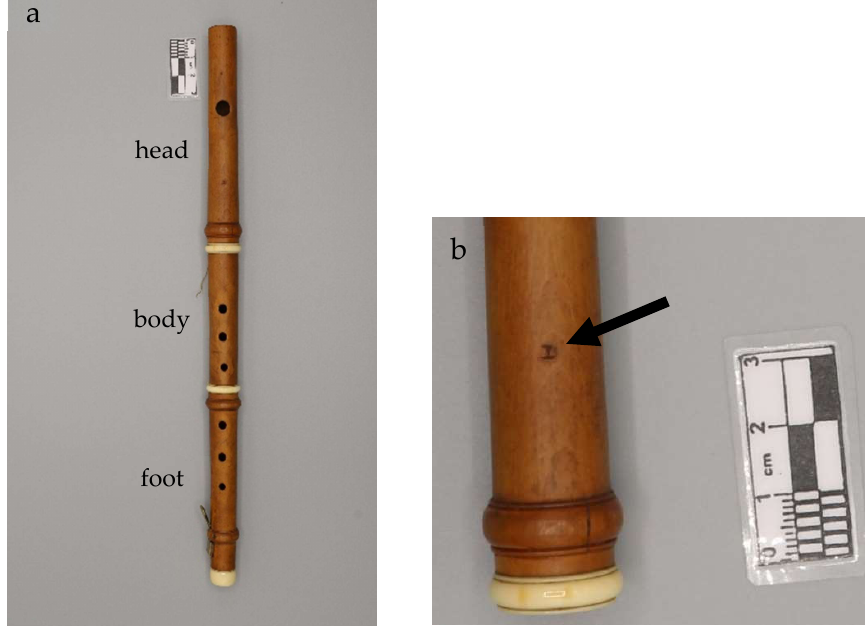
Figure 1. The analyzed woodwind instrument: ( a ) Piccolo Flute (tone in D), anonymous maker; ( b ) detail of the Piccolo Flute head, with the “D” marking (black arrow).